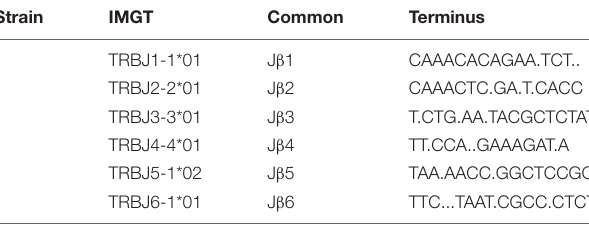
Sequences are shown in comparison to a representative gene segment. The strain of origin is indicated.